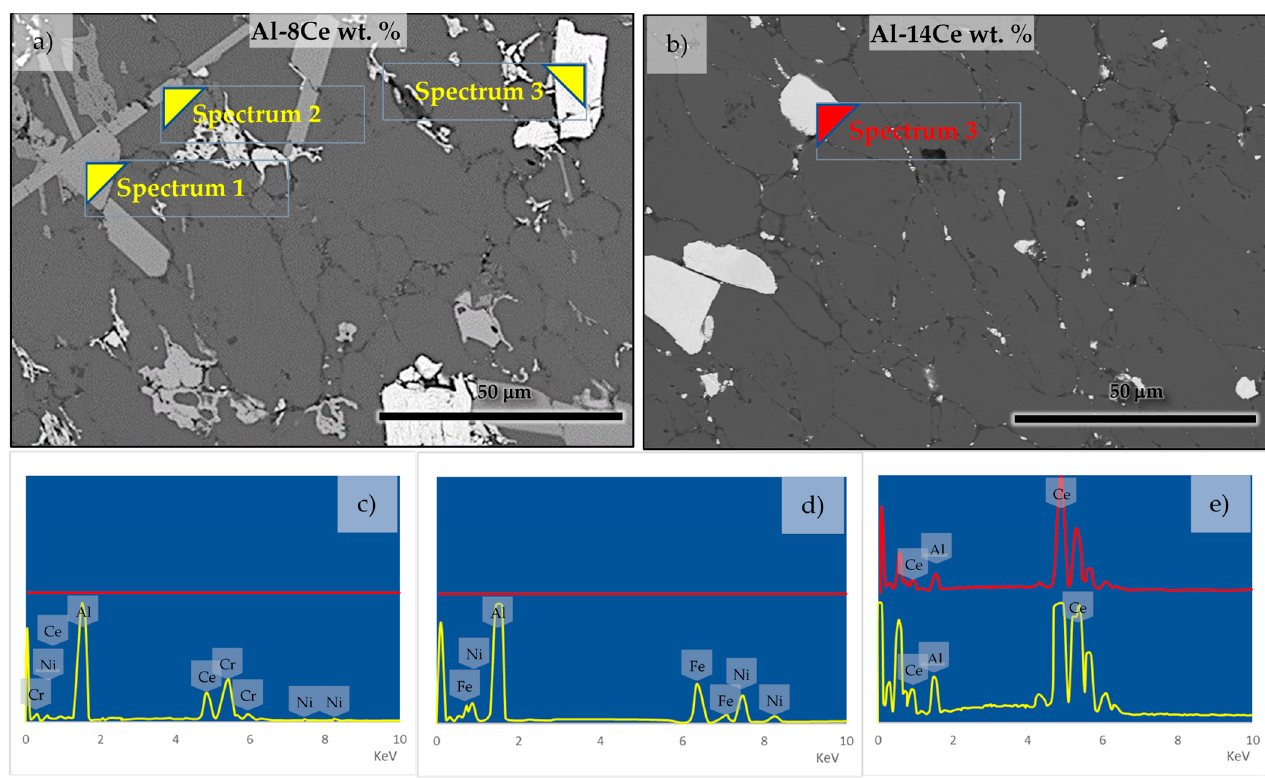
Figure 4. SEM point spectra of ( a ) Al-8Ce wt % and ( b ) Al-14 wt % processed via PIT. EDS spectrum ( c ) spectrum 1 ( d ) spectrum 2 and ( e ) spectrum 3 of Al-8Ce wt % (yellow) and Al-14Ce wt % (red). Table 1. EDS spectrum elemental composition in wt %.